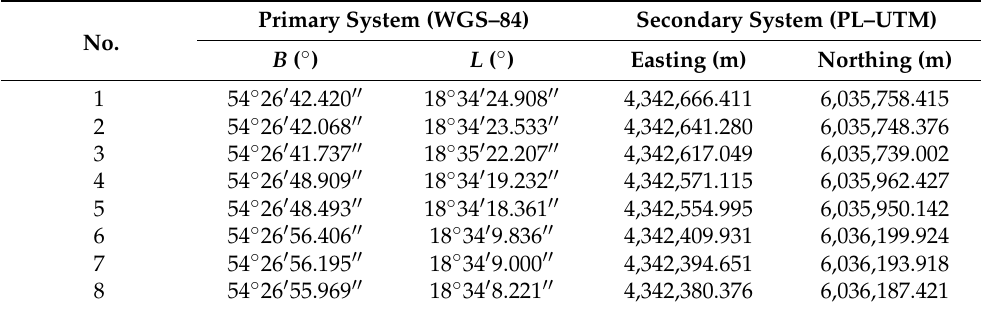
Table 1. Coordinates of the reference points in the coordinate system adopted as the primary coordinates (WGS–84) and coordinates of the reference points in the UTM system for the zone 34U. Primary System No.